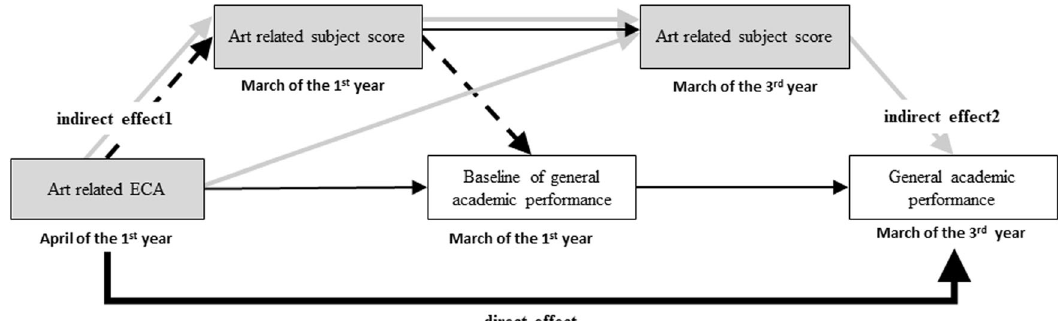
Fig. 1 The hypothesis model in the current study. Shaded boxes show students ’ art-related activity and grade scores and white boxes show the general ACGP. Bold line shows the direct effect of art-related ECA on general ACGP in the third year. Dotted line shows the indirect effect (indirect 1) of art-related ECA via art-related score in the fi rst year on general ACGP in the fi rst year. Gray line shows the indirect effect (indirect 2) of art-related ECA via art-related score in the fi rst and third years on general ACGP in the third year. ECA means extracurricular activity, ACGP means general academic score which is calculated by fi ve major subjects